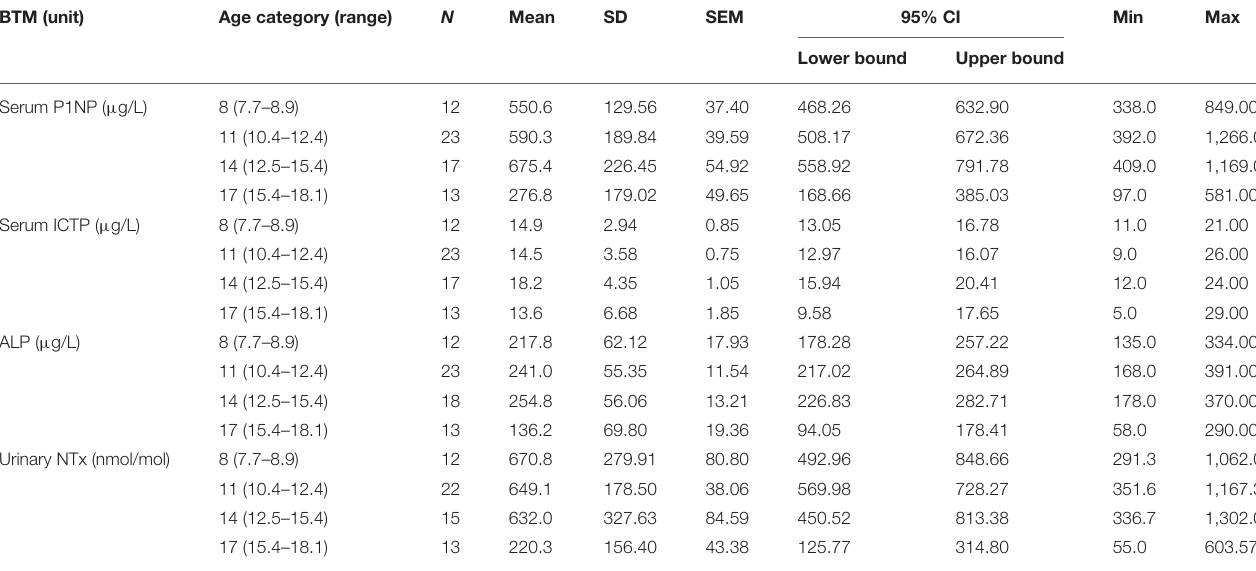
TABLE 1B | Serum P1NP, ICTP, ALP, and urinary NTx concentrations per age category for boys. BTM